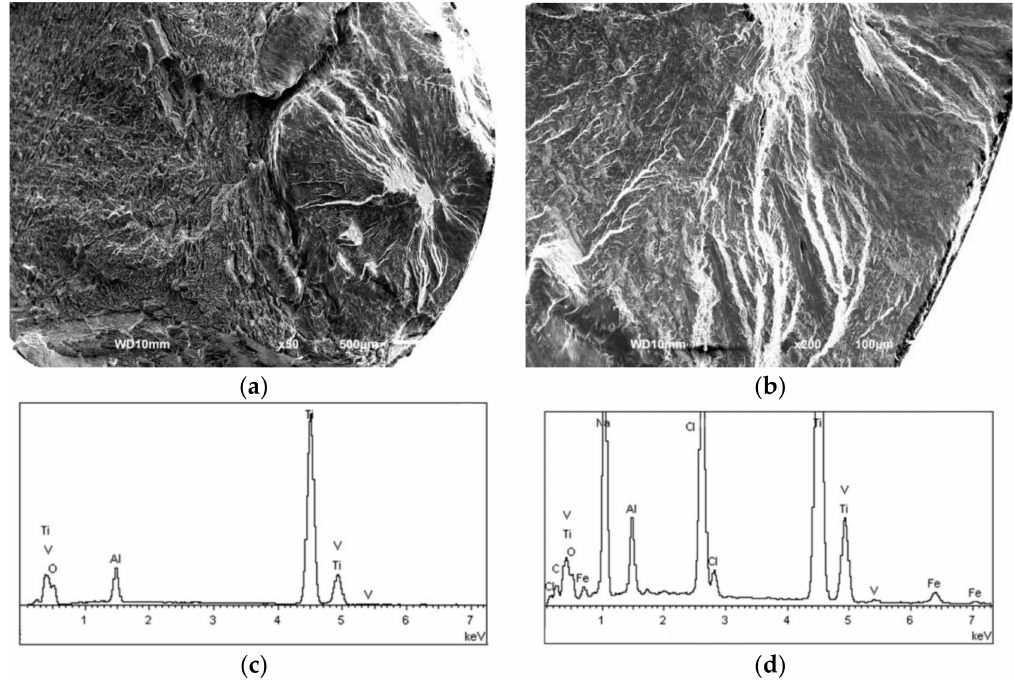
Figure 11. Fracture surface of TC4 (UNSM-SBF, 610 MPa, 2.12 × 10 6 cycles): ( a ) Overall view of fracture surface; ( b ) Edge nearby the crack initiation; ( c ) EDX analysis of crack core; ( d ) EDX analysis of the